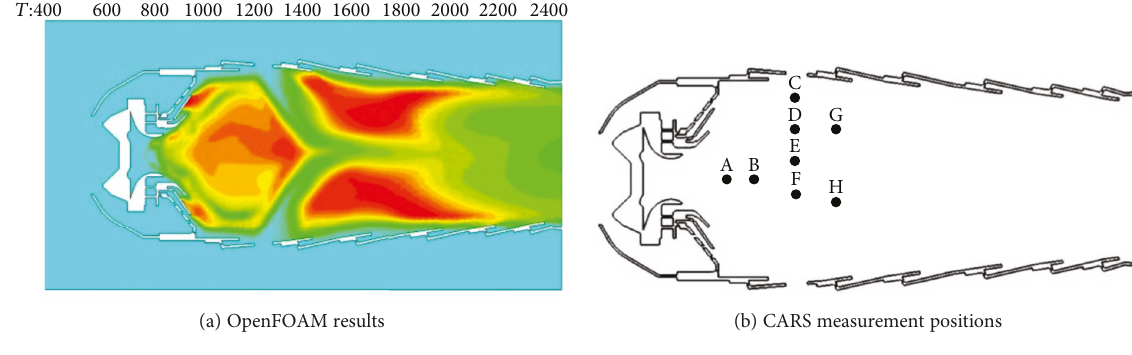
Figure 13: Temperature distribution and CARS measurement positions. Table 3: Comparison of the predicted combustor temperatures.